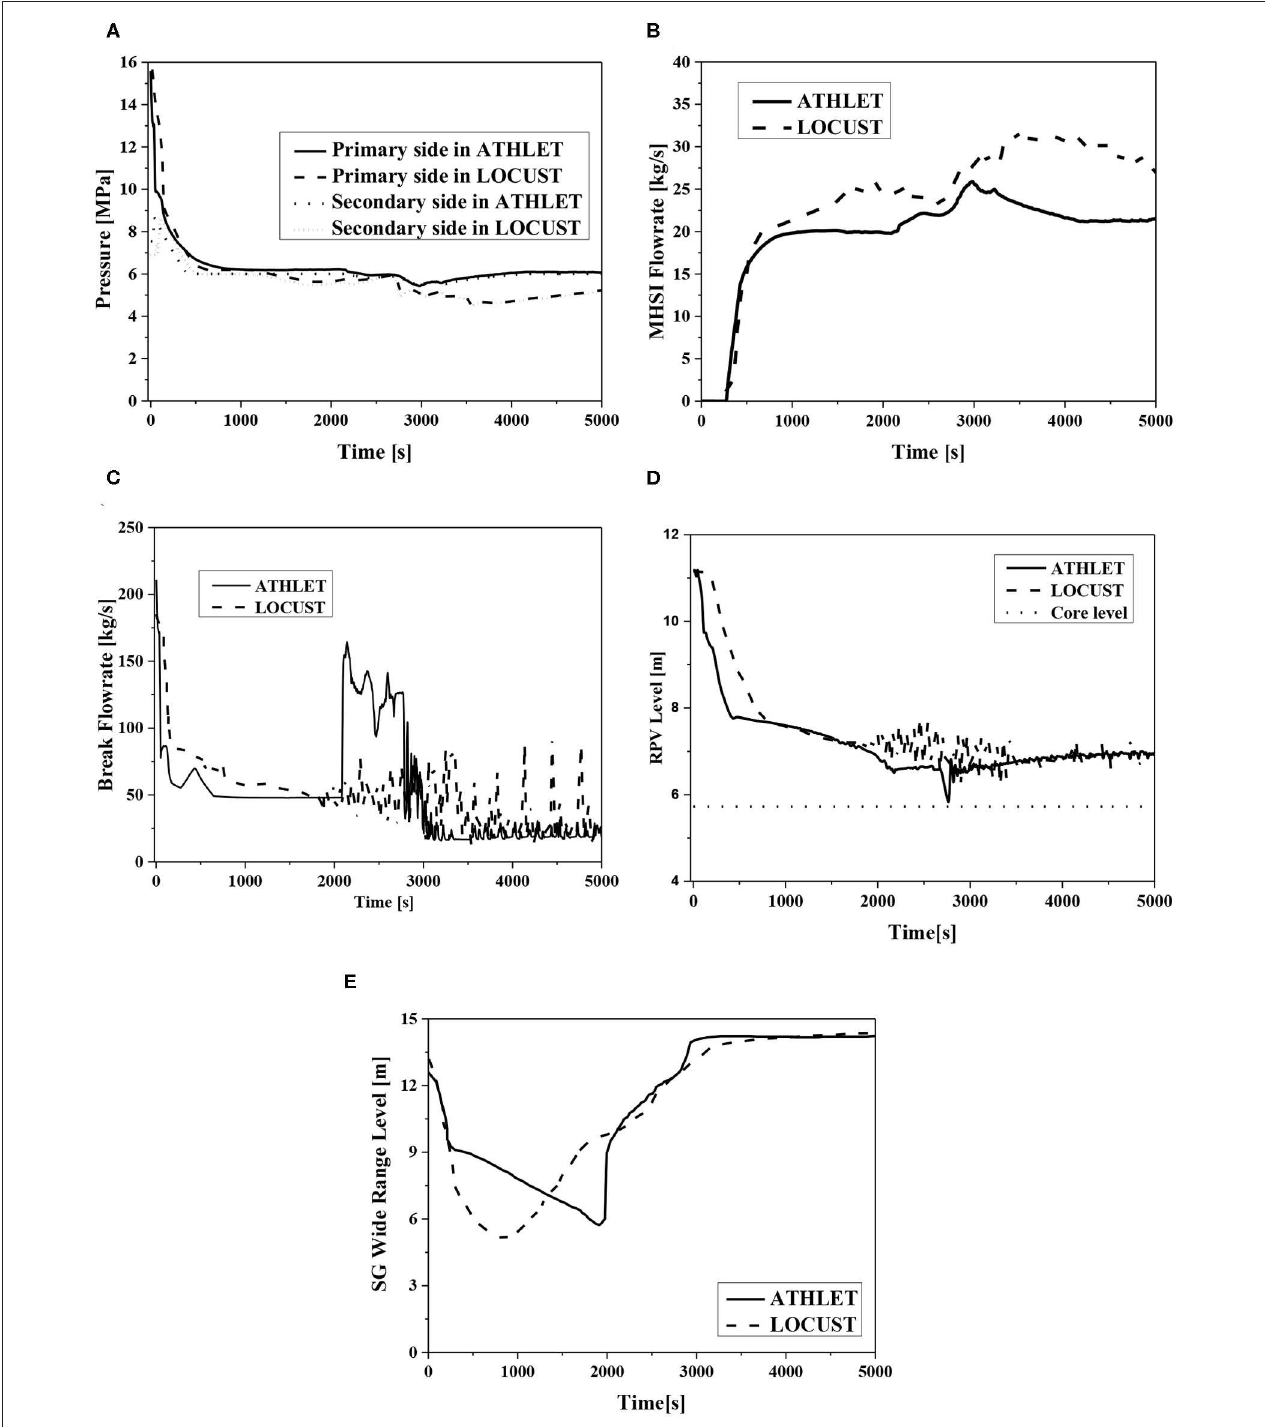
FIGURE 6 | Simulation results of SB-LOCA for HPR1000. (A) The pressure change. (B) The change of MHSI injection rate. (C) The change of break flowrate. (D) The change of RPV level. (E) The change of SG wide range level. the primary pressure at a stable level. To reduce the leakage thus the controlled state is reached. To eliminate the leak, the operator isolates the affected steam generator from both the flow, the operator can shut down two of the three MHSI steam side and feed side. The injection of MHSI maintains pumps. Due to the isolation of the SGa, the pressure of SGa